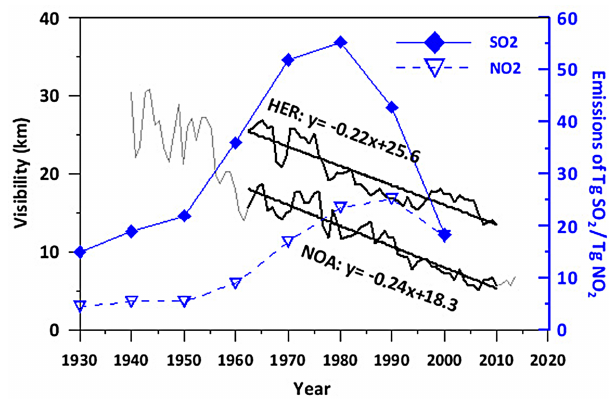
Figure 11. Interdecadal variability of the annual average visibil- ity at NOA (urban) and HER (background) stations. Bold black lines represent the common period of observations (1956–2009) at the two stations, along with linear trends and slopes. The solid blue line illustrates historical development of European emissions of SO 2 , as included in Vestreng et al. (2007), and the blue dashed line illustrates historical European emissions of NO x , as included in Vestreng et al.